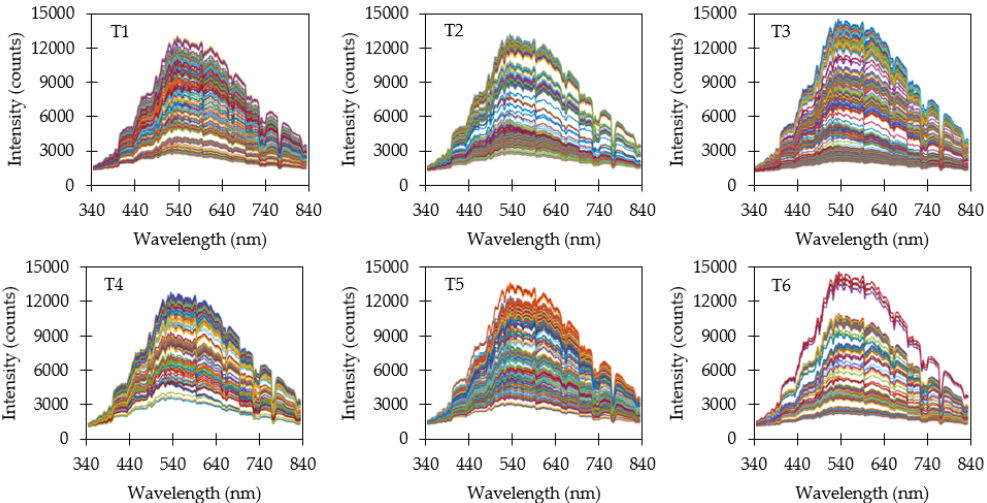
Figure 4. Raw ambient light intensity measurements from the VIS ambient light spectrometer. Each line represents a separate measurement. Line colors are arbitrary and used to help illustrate the number of distinct spectral measurements.